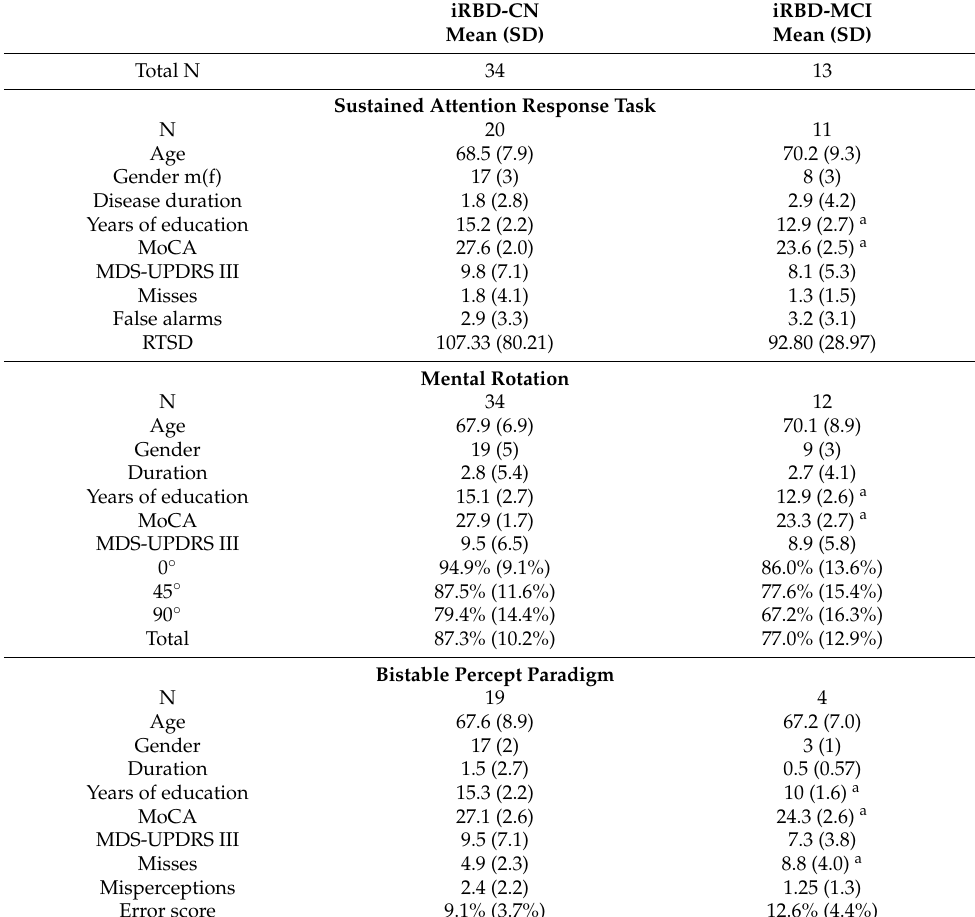
Table 1. Demographic and task